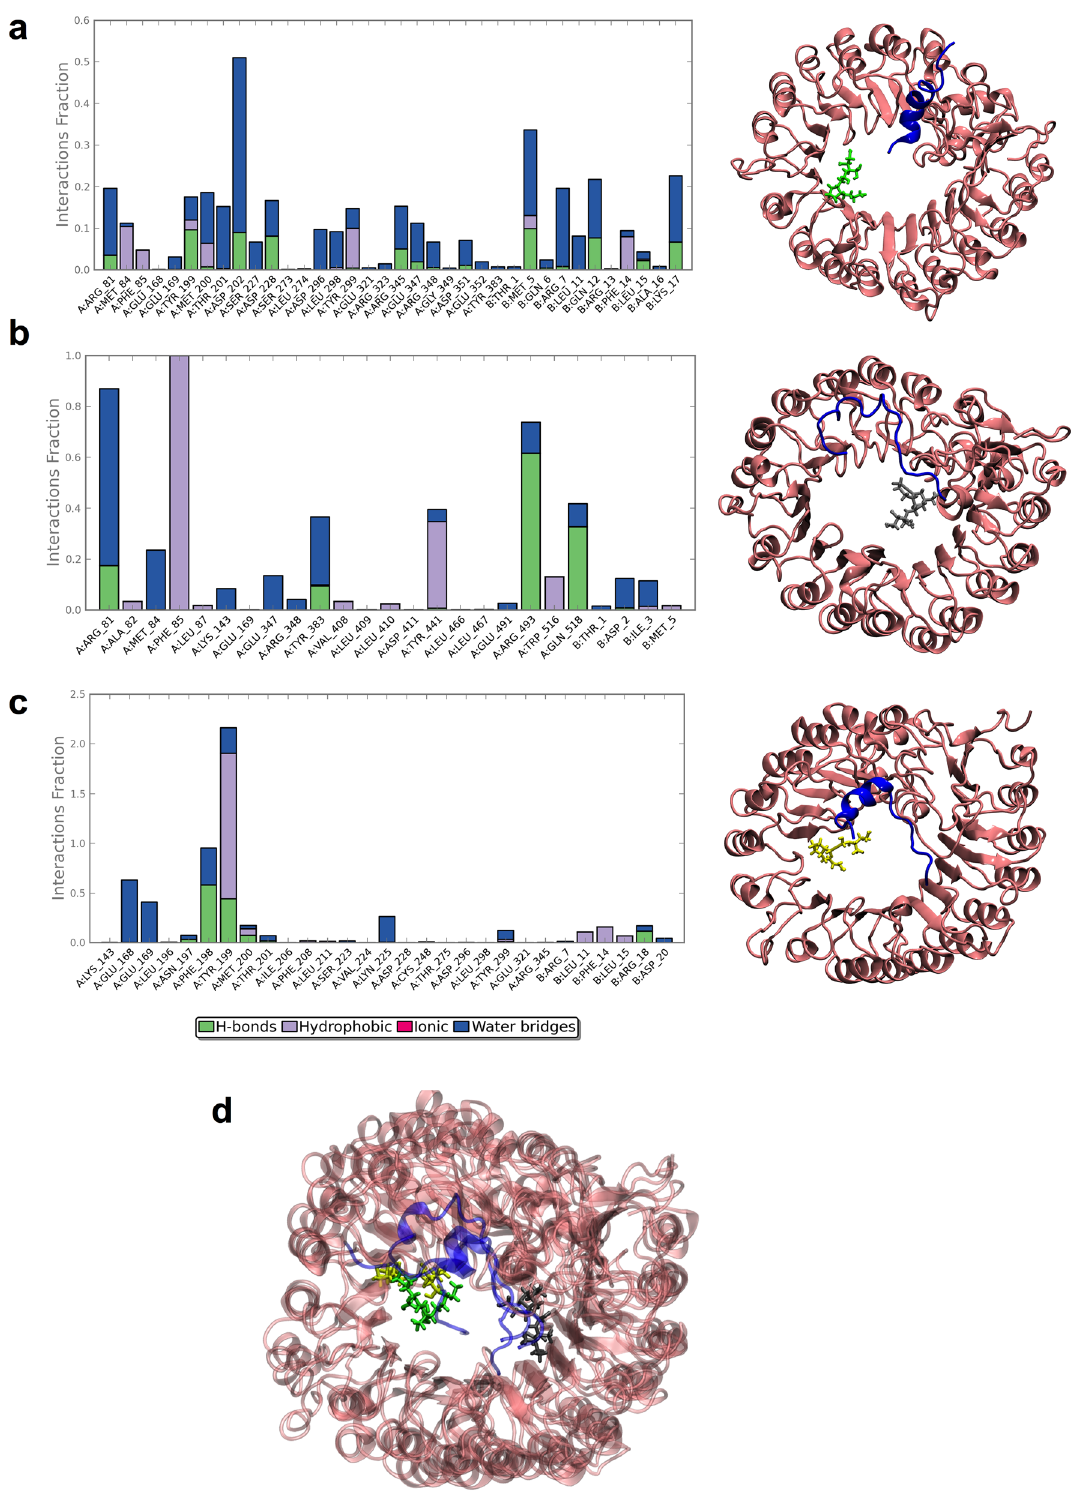
Figure 5. Protein–ligand interactions in each protein–ligand–protein complex. FaCOI1–FaJAZ1 and JA-Ile ( a ), FaCOI1–FaJAZ1 and COR ( b ), FaCOI1–FaJAZ1 and (−)-JA-Ile ( c ), and structural superposition of the three complexes described in a, b and c ( d ). Four types of interactions were described: the hydrogen bonds, hydrophobic interactions, ionic interactions, and water bridges are shown in green, purple, red, and blue, respectively. In the right panel, a representative view of the protein–ligand–protein interactions is shown for each complex. At, Arabidopsis thaliana ; Fa, Fragaria × ananassa ; COI1, CORONATINE INSENSITIVE1; COR, coronatine; JAZ, JASMONATE-ZIM